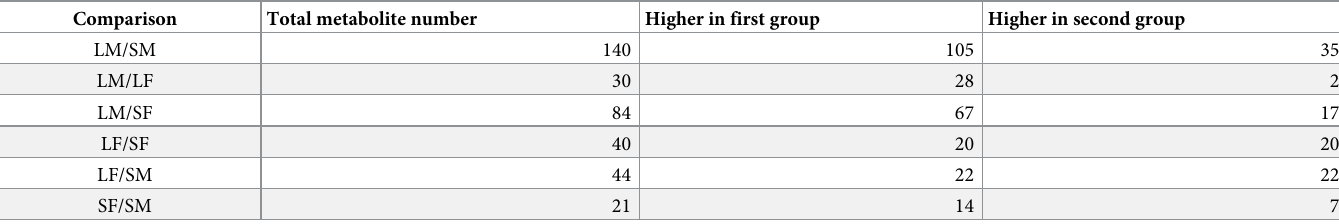
Table 1. Number of metabolites that showed significant differences through pairwise